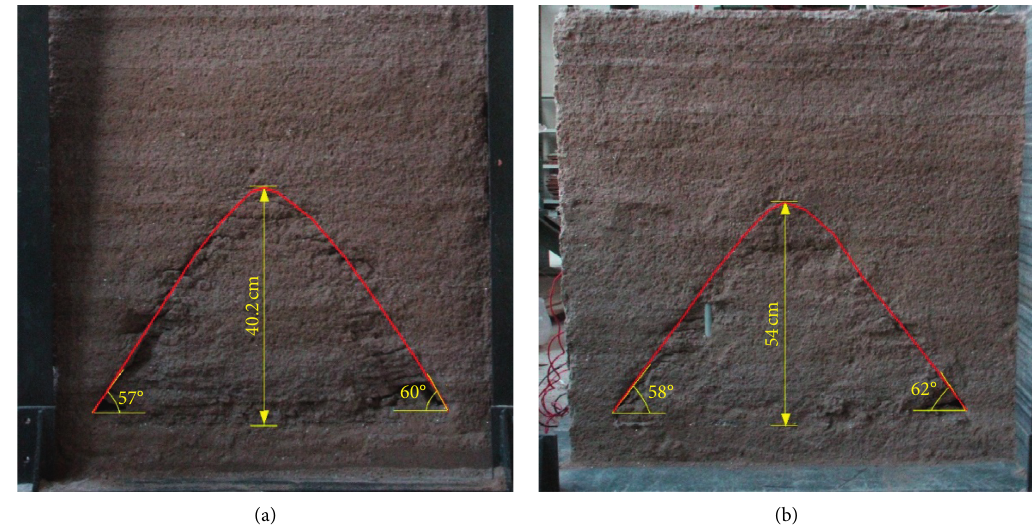
Figure 10: Pattern of fractures in the overlying strata. (a) Fracture pattern at y � 5. (b) Fracture pattern at y � 20.